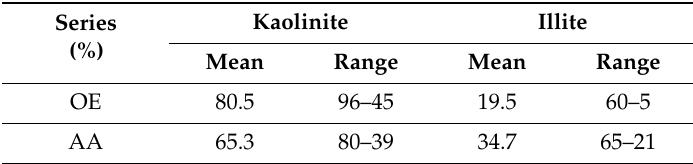
Table 2. Mineralogical composition of clay fractions (%kaolinite, %illite / muscovite). Mean value of the 60 samples analyzed, and ranges for each series (40 OE samples and 20 AA